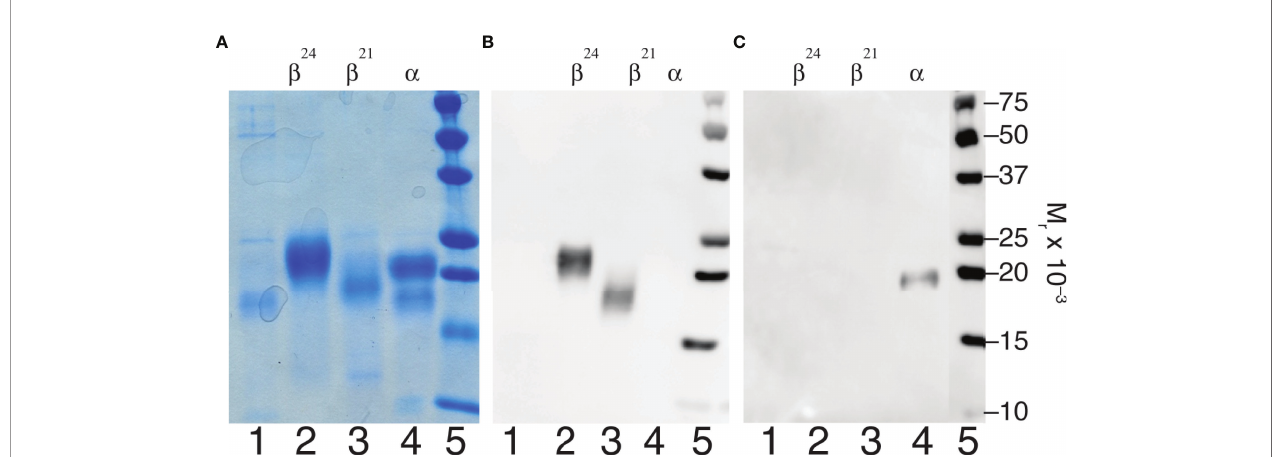
FIGURE 1 | FSH subunit puri fi cation. Characterization of subunits derived from highly puri fi ed human pituitary FSH (AFP7298A). (A) SDS-PAGE of 5 µg subunit samples followed by Coomassie Blue staining. (B) Anti-FSH b Western blot of 1 µg subunit samples using 15-1.E3.E5 as primary antibody. (C) Western blot of 1 µg subunit samples using anti-hCG a monoclonal antibody, HT13, as primary antibody. In both cases sheep anti-mouse IgG-HRP complex was the secondary antibody. Samples were loaded in the same order in each experiment. Lane 1, unbound material; lane 2, 24kDa-FSH b ; lane 3, 21kDa-FSH b ; lane 4, FSH a ; lane 5, BioRad molecular weight markers, as